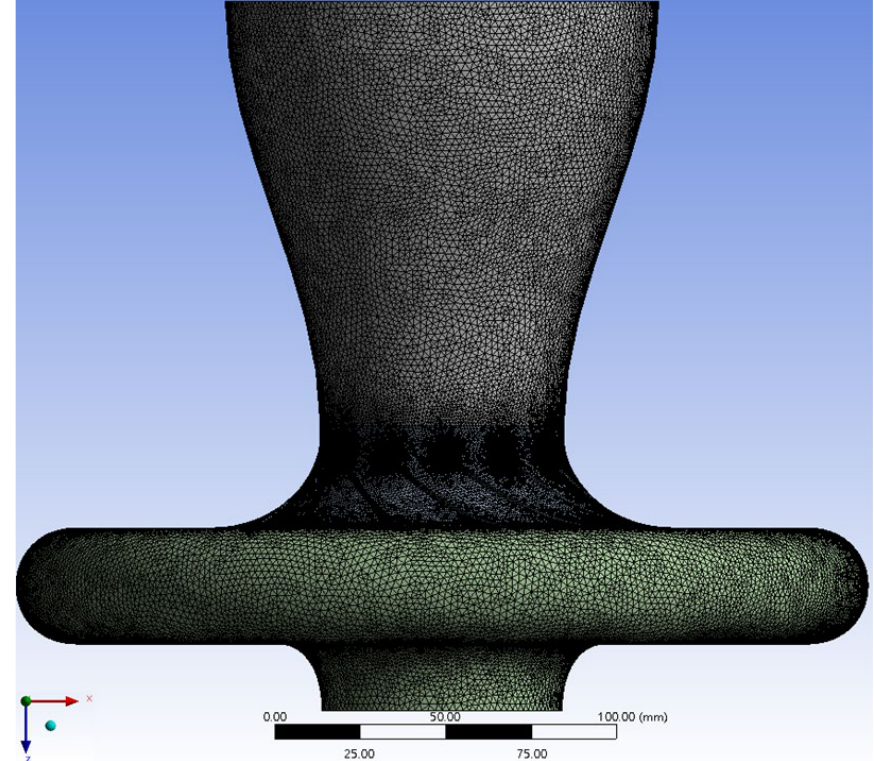
Figure 5. Global mesh for the first stage compression.